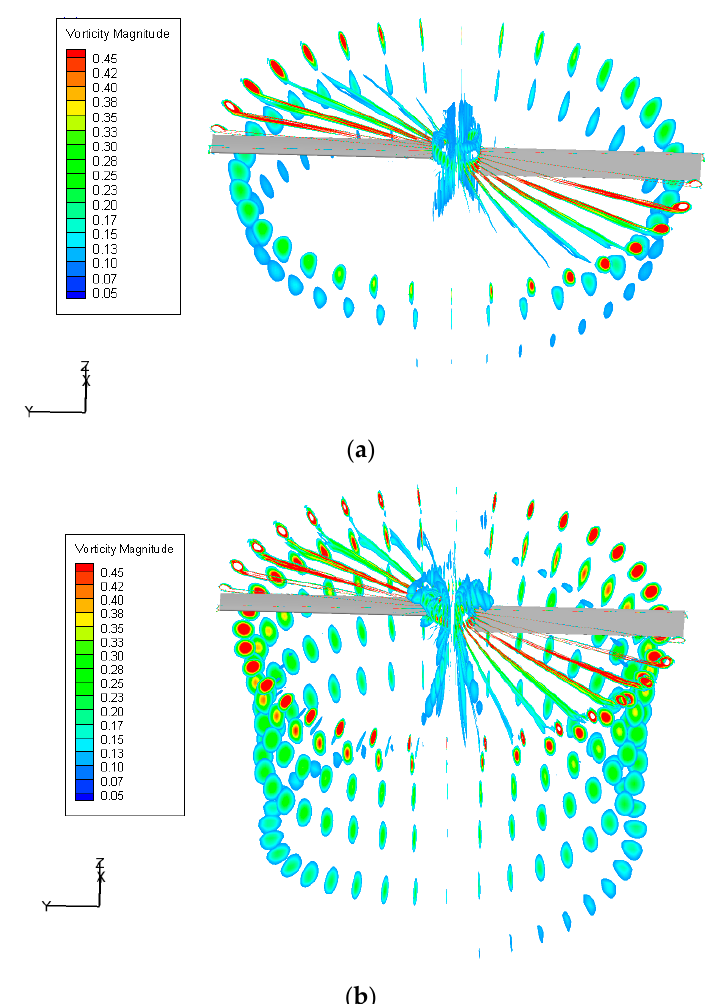
Figure 8. Comparison of vorticity distributions on radial sections. ( a ) MUSCL—Roe, ( b ) WENO—Roe.